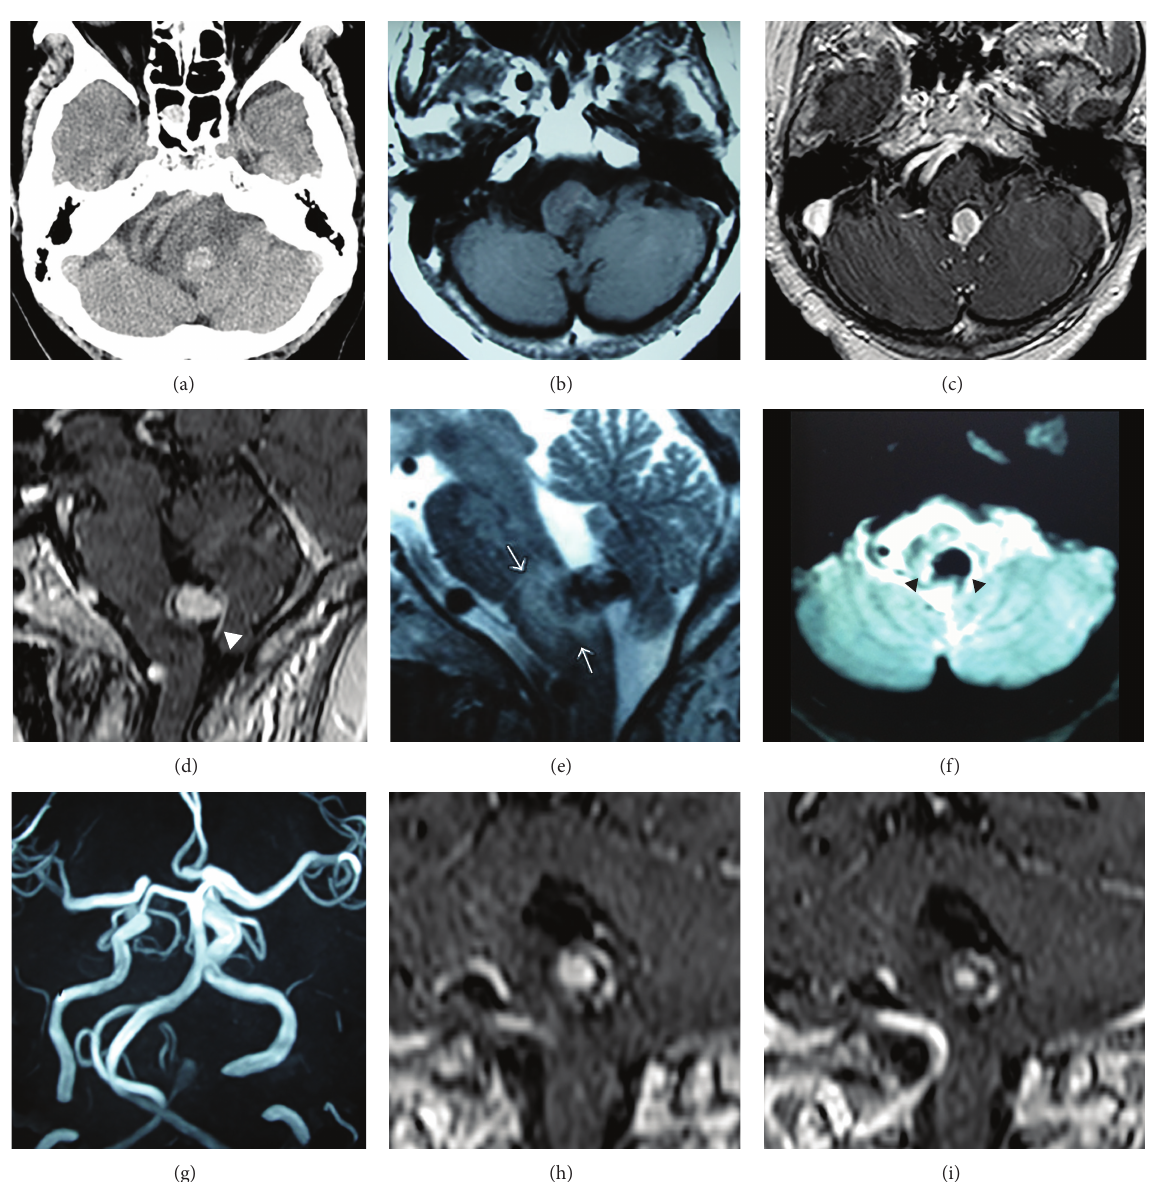
Figure 1: Noncontrast enhanced CT brain showing a hyperdense midline lesion of the posterior fossa ((a), axial). T1W MRI sequences depict a hypointense lesion, apparently intra-axial, arising from the floor of the fourth ventricle compressing against the superior medulla ((b), axial). The lesion demonstrates gadolinium contrast enhancement and is abutting the PICA, white arrowhead ((c), T1W contrast, axial; (d), sagittal). T2W MRI revealing significant perilesional medullary edema, white arrows ((e), sagittal). SWI sequence showing blooming artifacts within the lesion and its proximity to the PICA, black arrowheads ((f), axial). Three-dimensional reconstructed contrast-enhanced MRA showing no detectable vascular lesion (g). The “target” sign is observed only in the coronal contrast T1W images ((h), (i)).